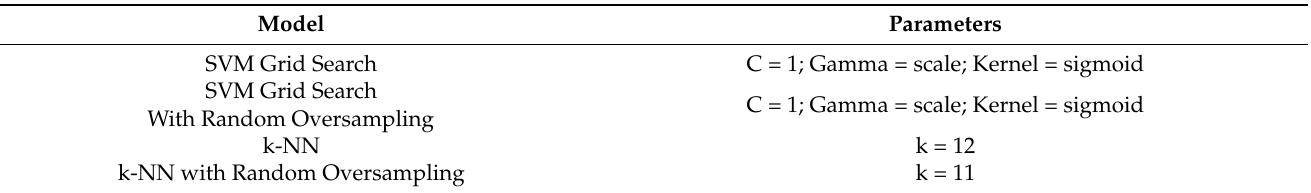
Table 3. Parameters of the models for the prediction of lower extremity injuries and injuries in the Torso and hands